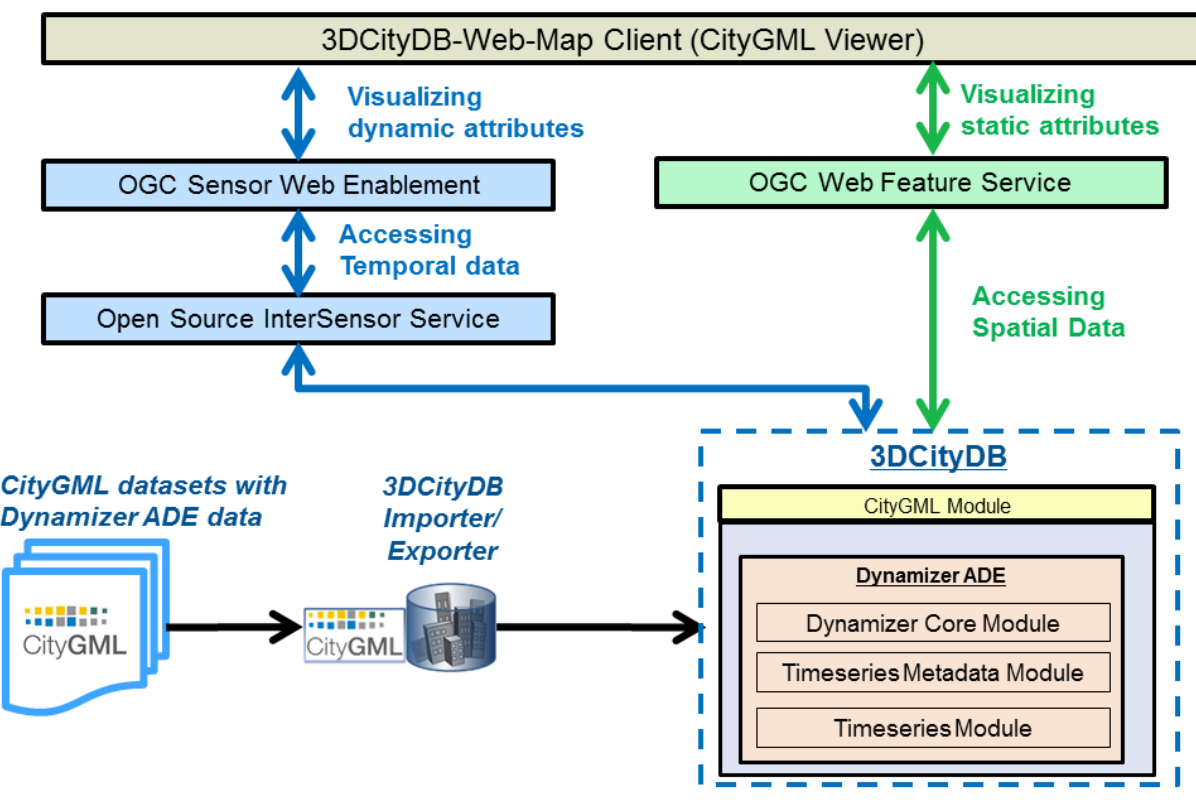
Figure 2. High Level Overview of Managing and Visualizing Static and Dynamic data using CityGML Dynamizers (i) Dynamizer id , (ii) attributeRef , (iii) startTime , and